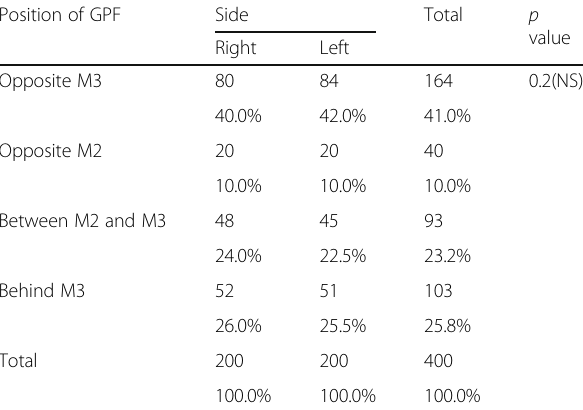
Table 1 Frequency and percent of position of the GPF based on side